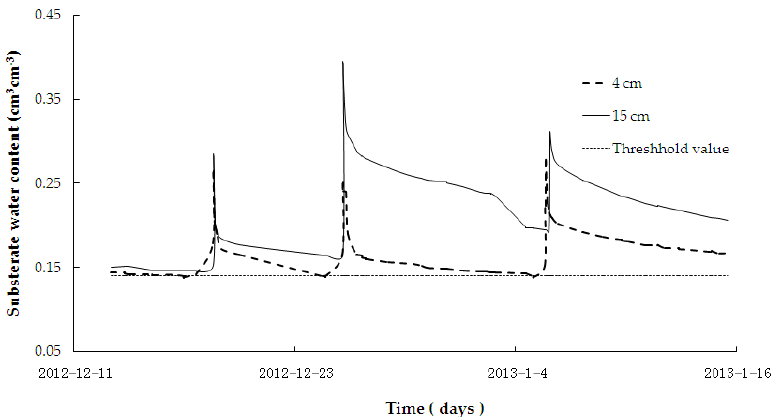
Figure 5. Substrate water content measured by EC-5 sensors at two depths of 4 cm and 15 cm. Table 5. Total irrigation, leakage, and leakage rate.